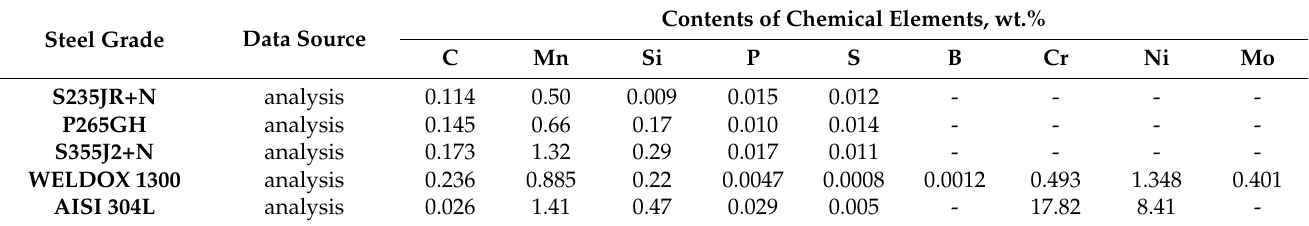
Table 1. Chemical composition of steel grades.